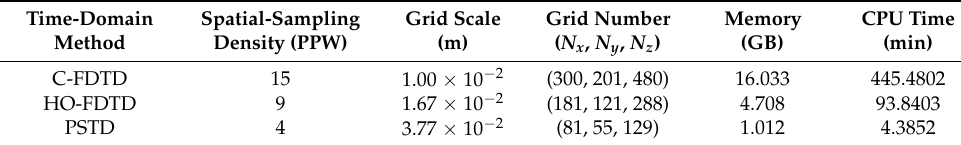
Table 3. Computational Efficiencies of RTM Imaging Methods with Three Schemes.